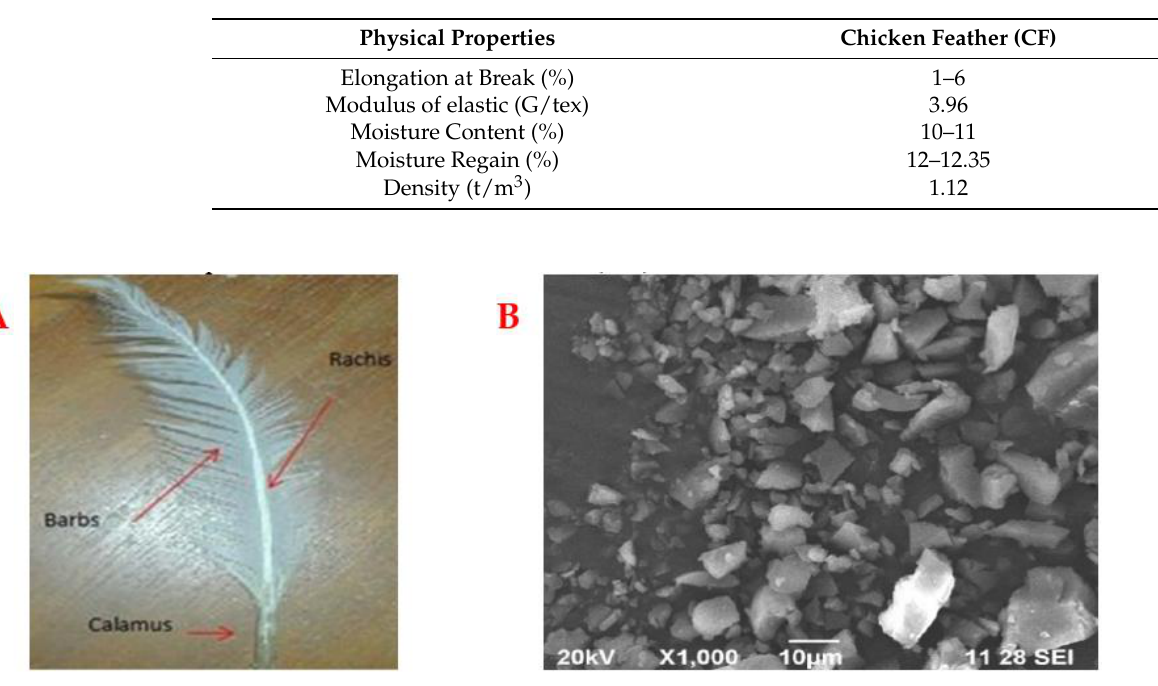
Figure 3. ( A ) Photograph of a chicken feather showing rachises and barbs. ( B ) SEM image of chicken feather sand. Table 2. Elemental composition of a chicken feather (CF).